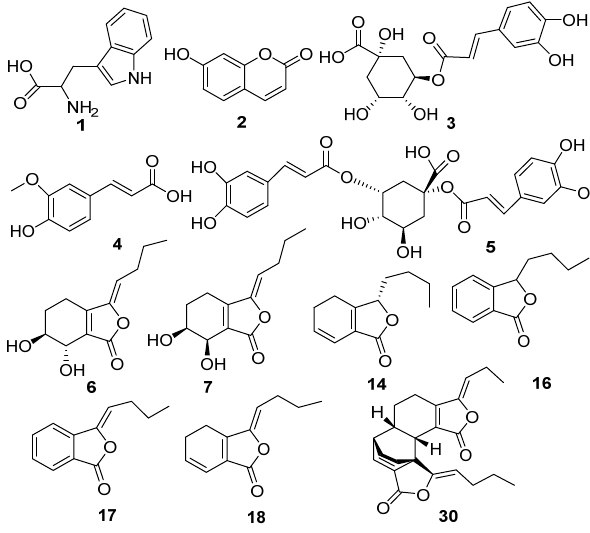
Figure 3. Structures of main compounds in RAS. Table 2. Mass data of compounds detected in